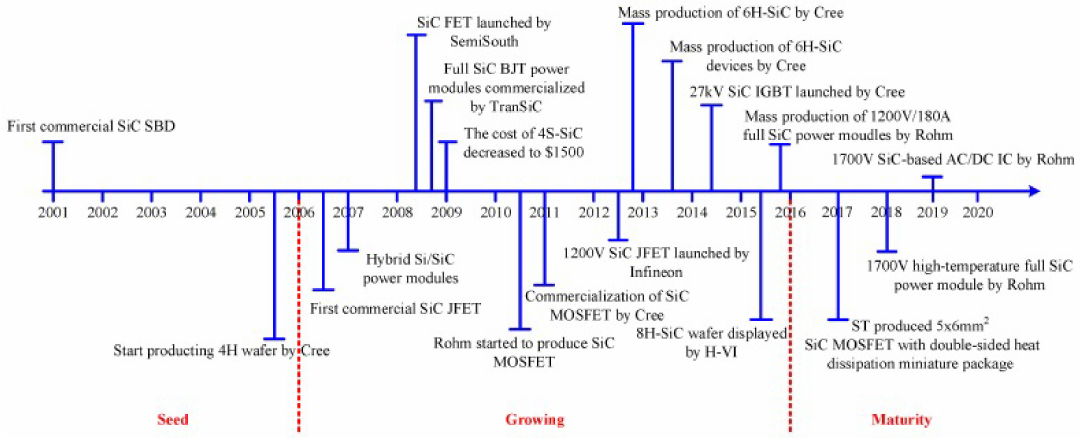
Figure 2. The development of SiC-based devices over the year